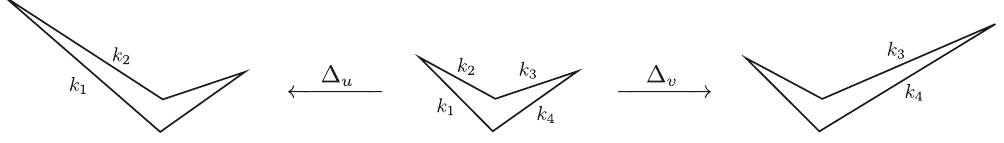
Figure 3. The four-point point function arising from tree exchange in the s -channel satisfy a pair of ordinary di(cid:11)erential equations (2.33), that determine the dependence as u or as v ( k 3 + k 4 ) (cid:0) 1 is varied. These correspond to two di(cid:11)erent \holographic" pictures for time / evolution, which are nontrivially mutually